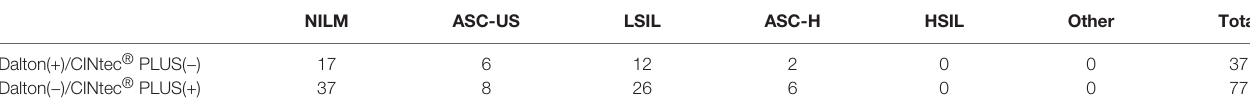
TABLE 3 | Disagreement between Dalton and CINtec ® PLUS p16/Ki-67 Dual Stain in different cytology groups a,b .